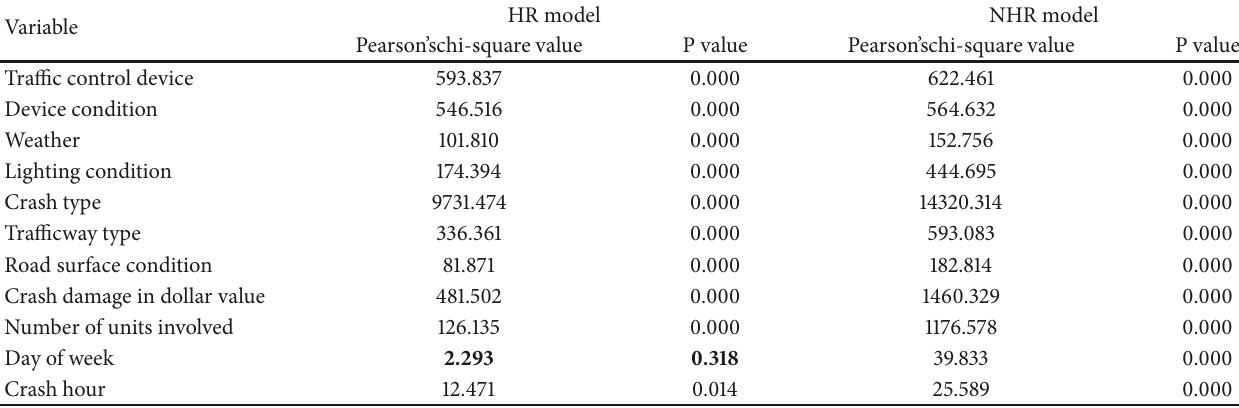
Table 2: Results of Pearson’s chi-square